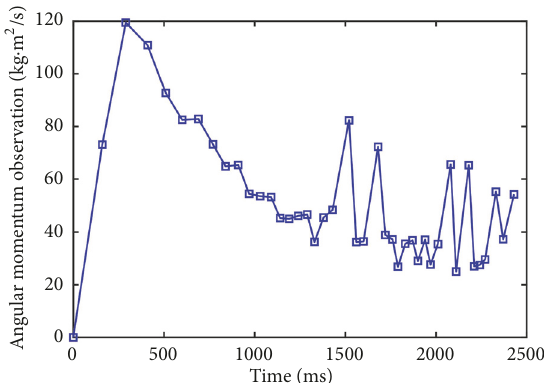
Figure 10: Load momentum observation during AMT startup under the third gear.